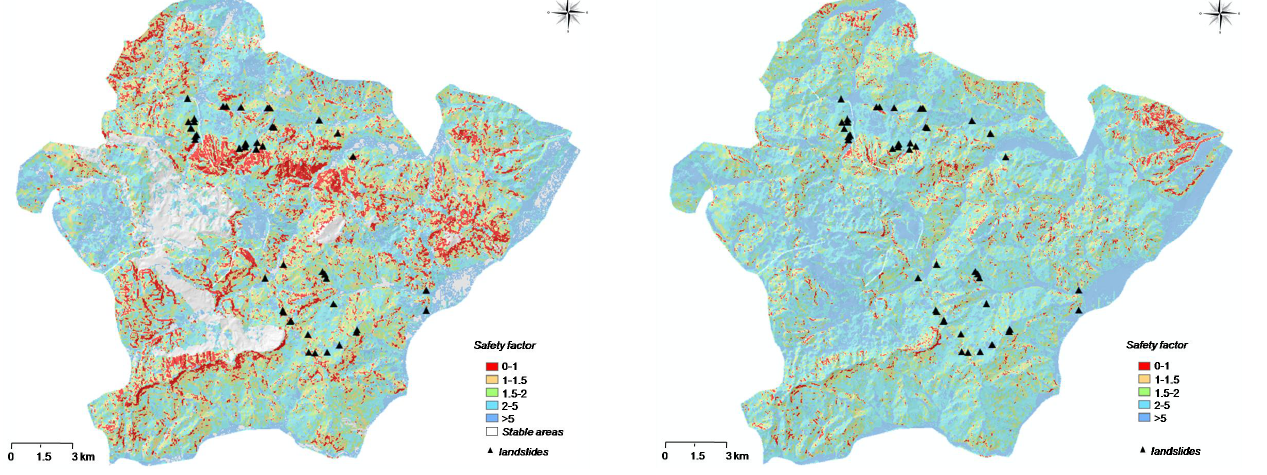
Fig. 10. TRIGRS analysis on the test-area: safety factor map and Fig. 9. SLIP analysis on the test-area: safety factor map and local- localization of soil slips occurred on the 11 April 2005. Figure 9. ization of soil slips occurred on the 11 April 2005. Figure 10